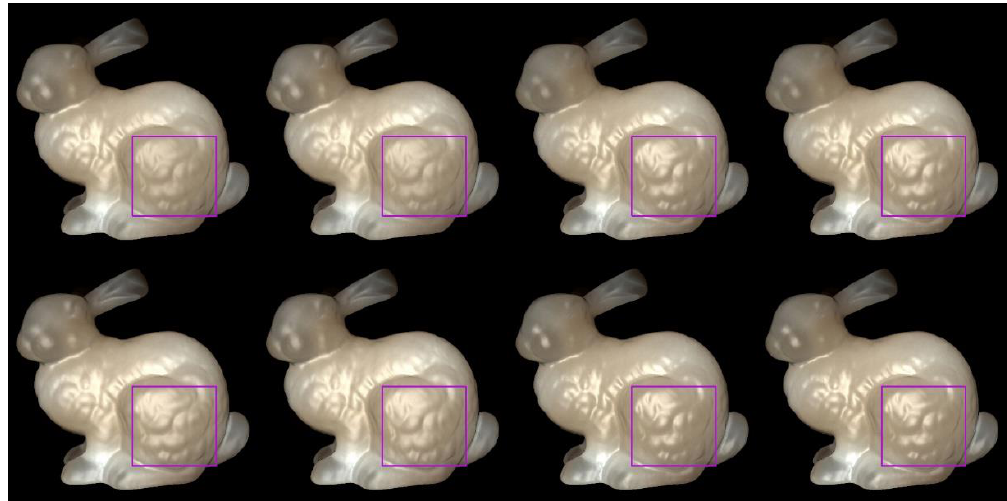
Figure 5. Comparison of highlight effects generated by our Lafortune-based method (first row) and the method based on the traditional Lafortune model (second row) for marble material. From left to right, the n t , n b parameters are n t is 0.2, n b is 0.5; n t is 0.5, n b is 0.2; n t is − 0.2, n b is − 0.5; n t is − 0.5, n b is − 0.2.